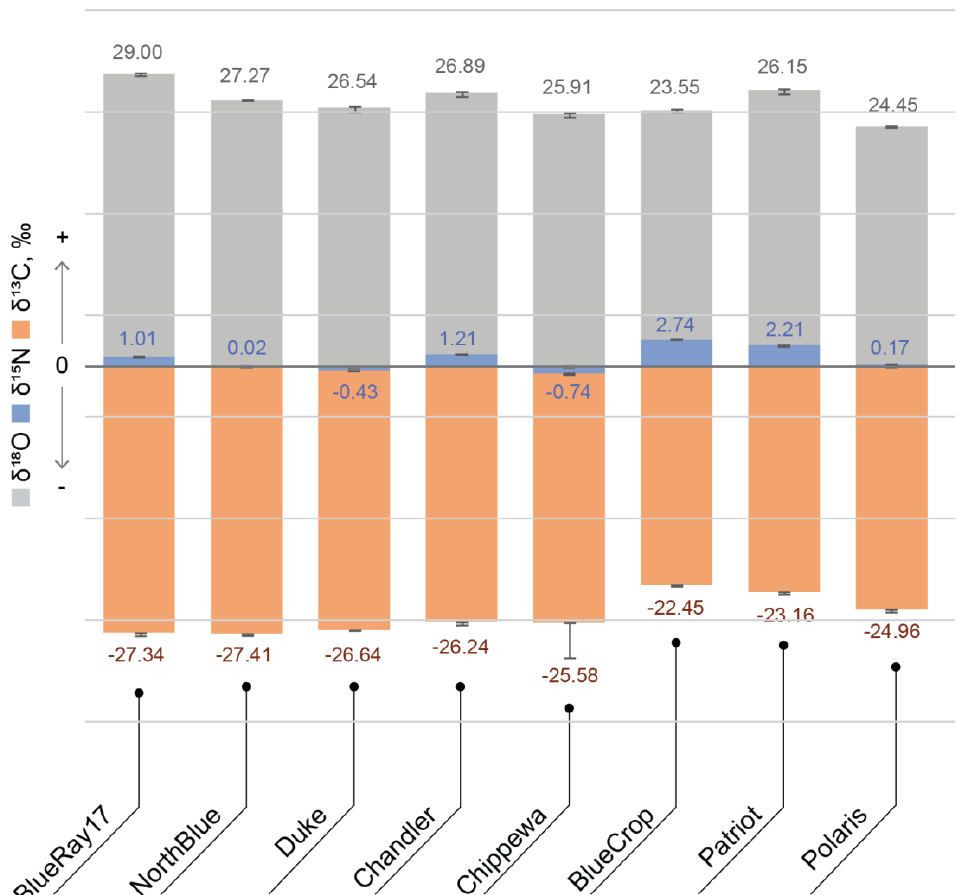
Figure 3. Light stable element isotope (δ 13 C, δ 15 N, δ 18 O) ratio values in different varieties of blueberry from one location in Latvia. Error bars represent standard error between the replicates ( n = 5).